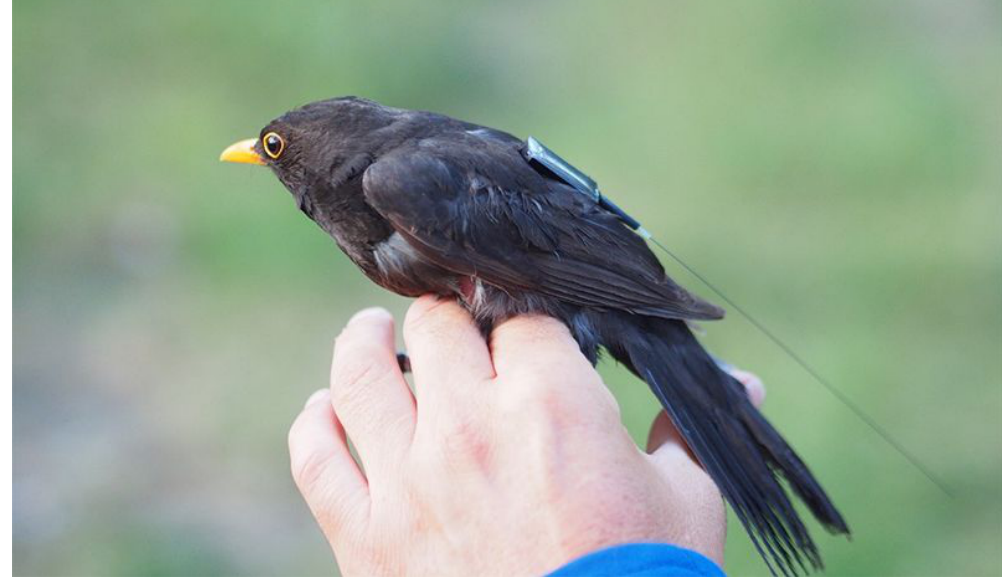
Figure 2. ICARUS tag on a blackbird. Credit: Max Planck